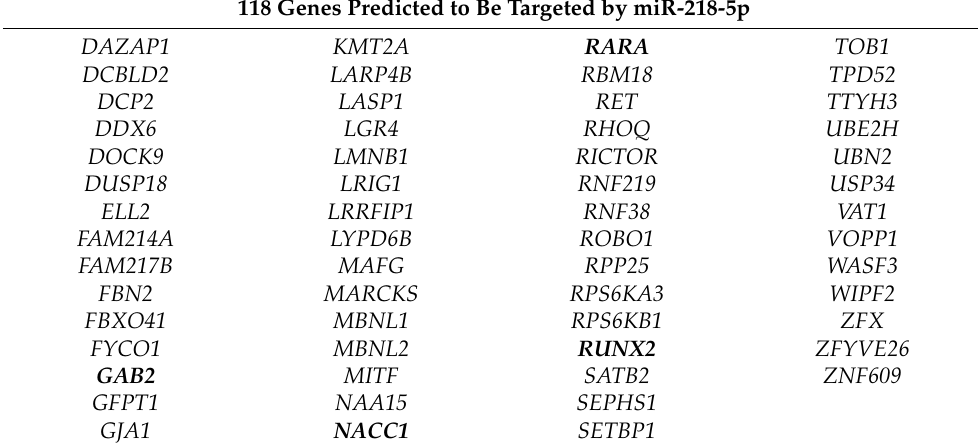
Table 1. Cont. 118 Genes Predicted to Be Targeted by miR-218-5p